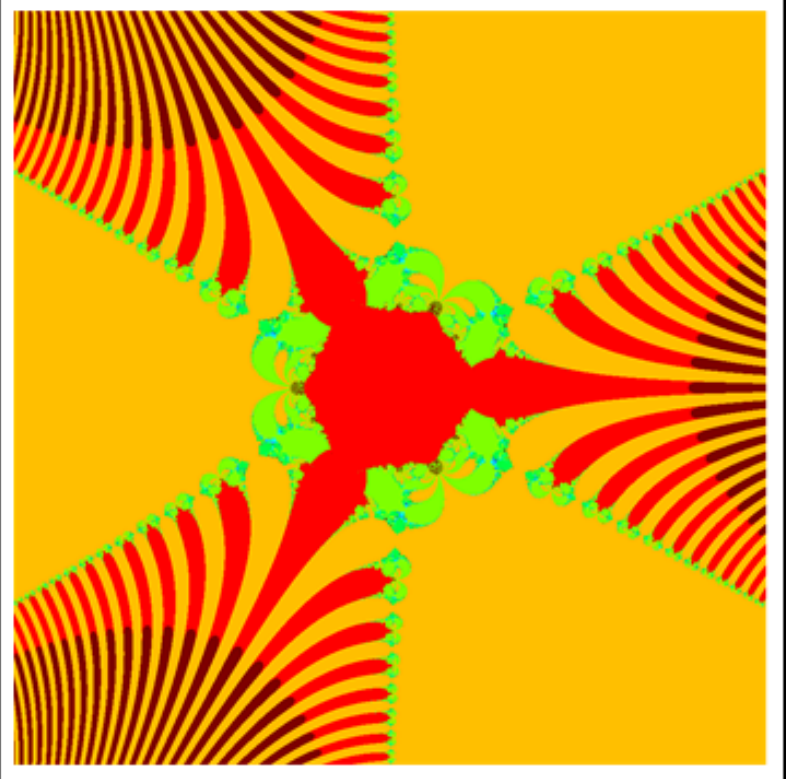
Figure 17. J-set for τ ( z ) = e z 3 + c via DKIS. The image execution time is 112.281